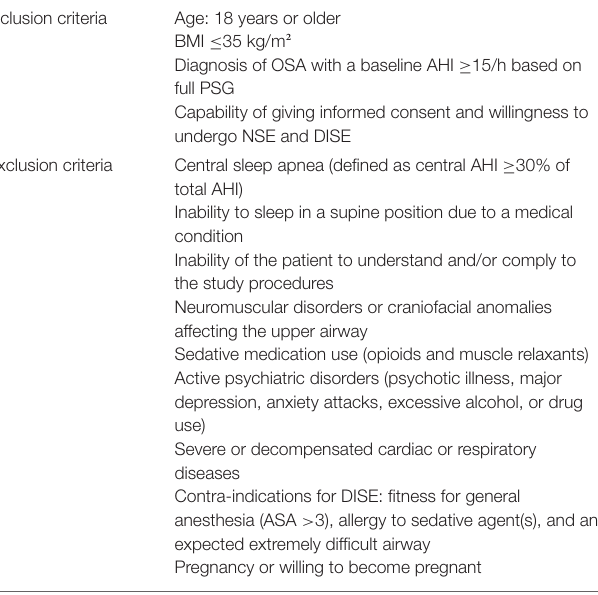
TABLE 1 | Eligibility criteria. Inclusion criteria